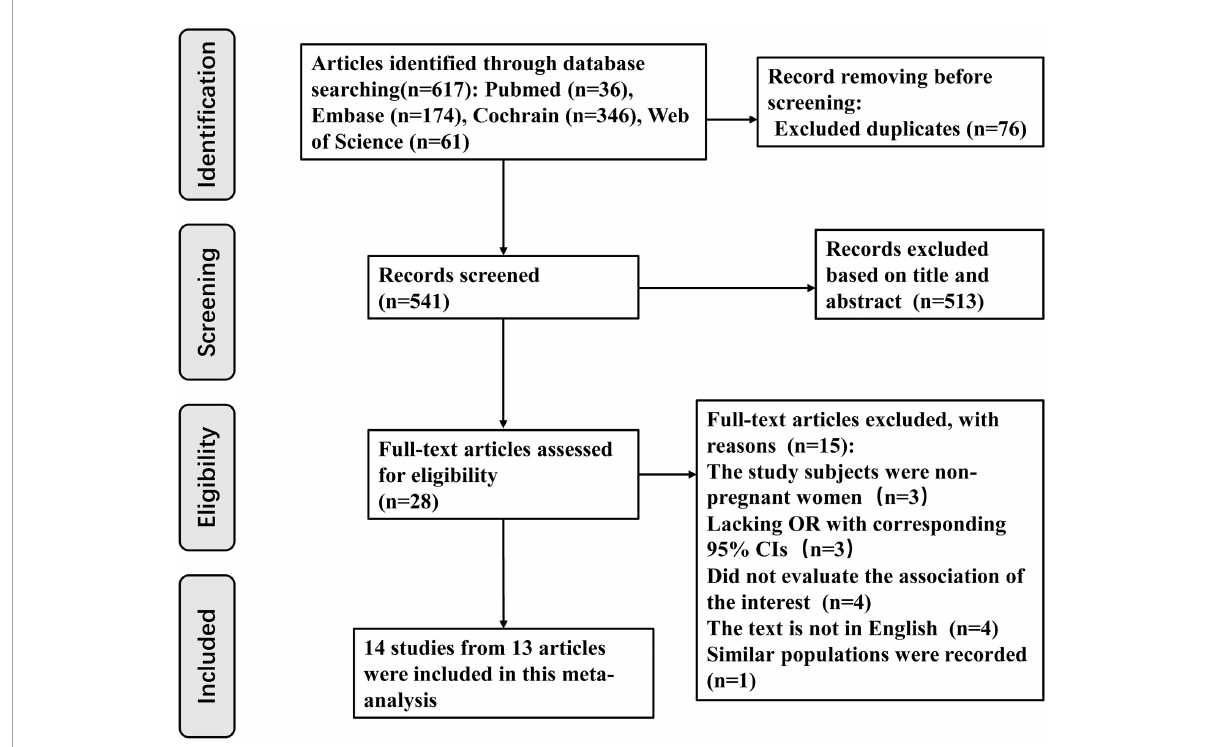
FIGURE1 Flow chart of the selection of studies included in this